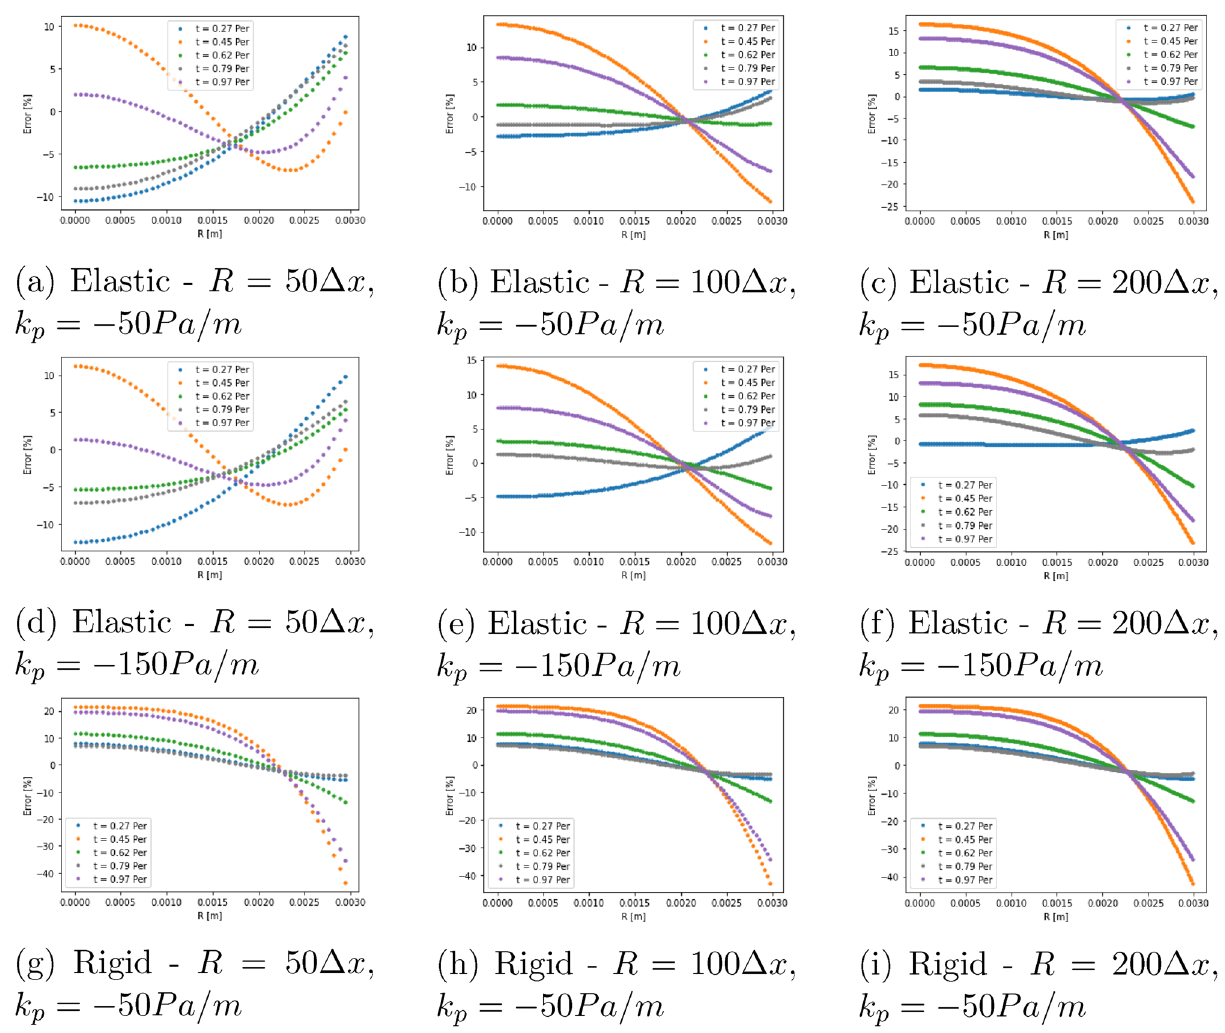
Figure 3. Relative error at the centre plane of the test cylinder comparing the current elastic wall model to the 50 Pa/m and ( d )–( f ) k p 150 Pa/m. ( g )–( i ) elastic wall analytical equations for the cases of ( a )–( c ) k p = − = − 50 Pa/m. Note the significantly compare the rigid wall model to the elastic wall analytical equations for k p = − larger error at the walls compared to the equivalent results for the elastic wall model, In all cases, the centre of 0.0 m and the edge at R 0.003 the cylinder is at R = =